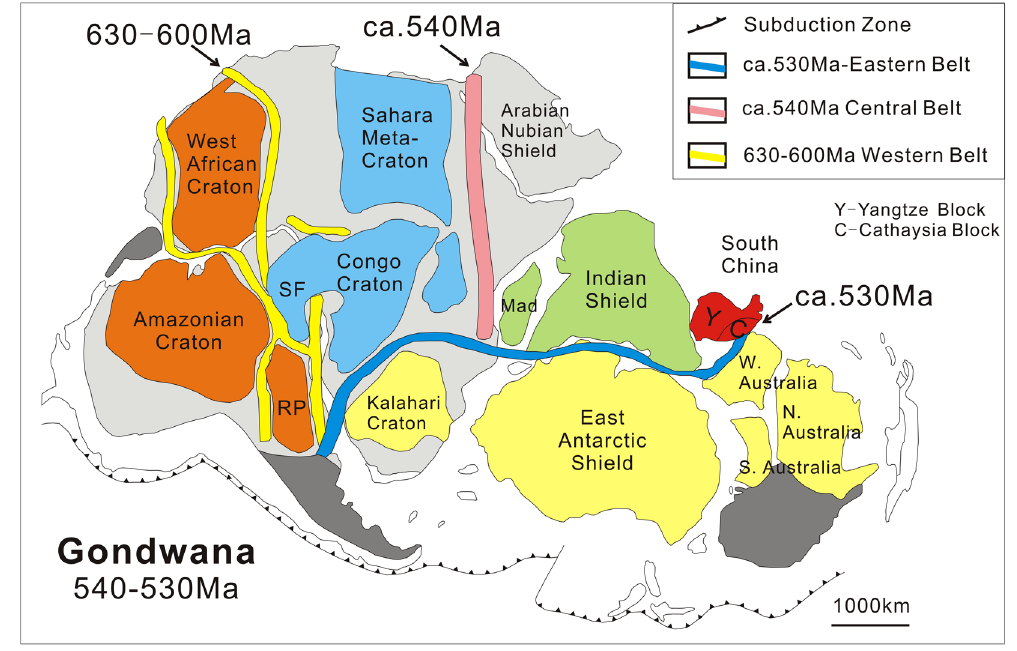
Figure 6. Gondwana reconstruction diagram showing the location of South China Block at 540–530 Ma (modified after Santosh et al . 9